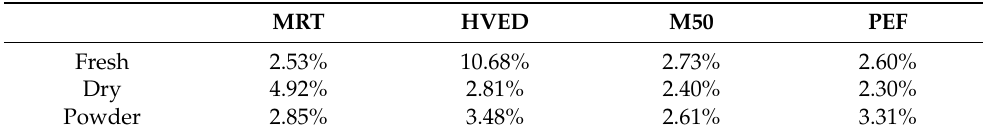
Table 3. Relative content of MAAs in treated